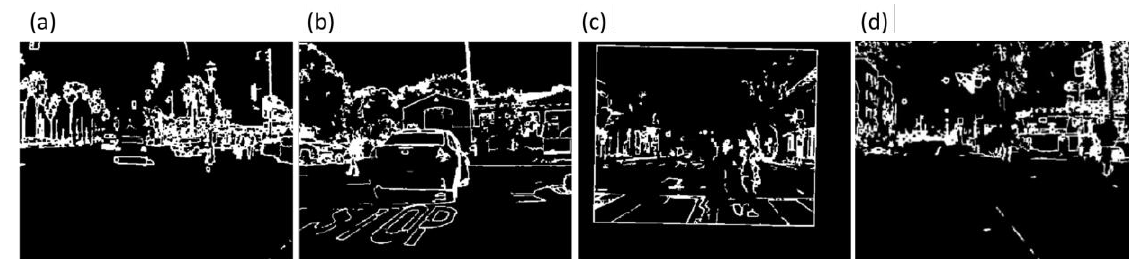
Figure 5. RF_VisMask. daylight image FLIR_02163 ( a ); daylight image FLIR_05011 ( b ); nightlight image FLIR_05697 ( c ); and nightlight image FLIR_08926 ( d ). Proposed Anomaly-Based Pre-Process